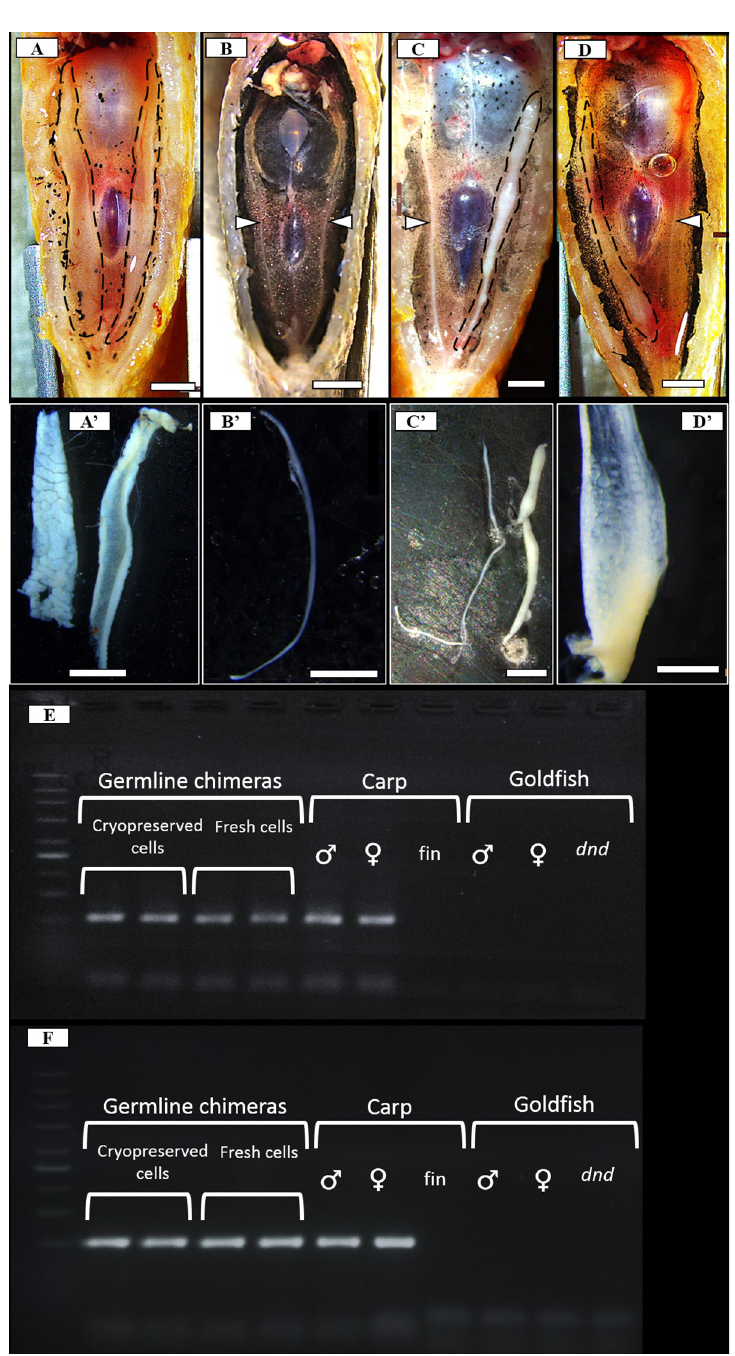
Fig 2. Detection of common carp spermatogonia incorporation and proliferation after interspecific transplantation into sterilized goldfish recipients. (A-D) Ventral view of dissected goldfish recipients. (A’-D’) Stereomicroscopic observation of the dissected gonads. (A, A’) Control fish displaying both gonads fully developed. (B, B’) dnd -MO treated goldfish displaying a lack of gonadal development. Development of testis (C, C’) and ovary (D, D’) after transplantation of common carp spermatogonia into dnd -MO sterilized goldfish recipients. Developed gonads are outlined with black dashed lines, undeveloped gonads are pointed out by white arrowheads. Scale bars: A, A’, B, C, C’, D– 2 mm, B’– 1 mm, D’– 500 μ m. (E,F) Gel electrophoresis of RT-PCR amplicons of common carp vasa (E) dnd1 (F) from gonads of goldfish germline chimeras transplanted with cryopreserved/thawed cells or fresh cells, control common carp ovary ( ♀ ), testes ( ♂ ) and fin tissue (fin), goldfish control ovary ( ♀ ), testes ( ♂ ), and gonads of dnd -MO injected fish ( dnd -MO).